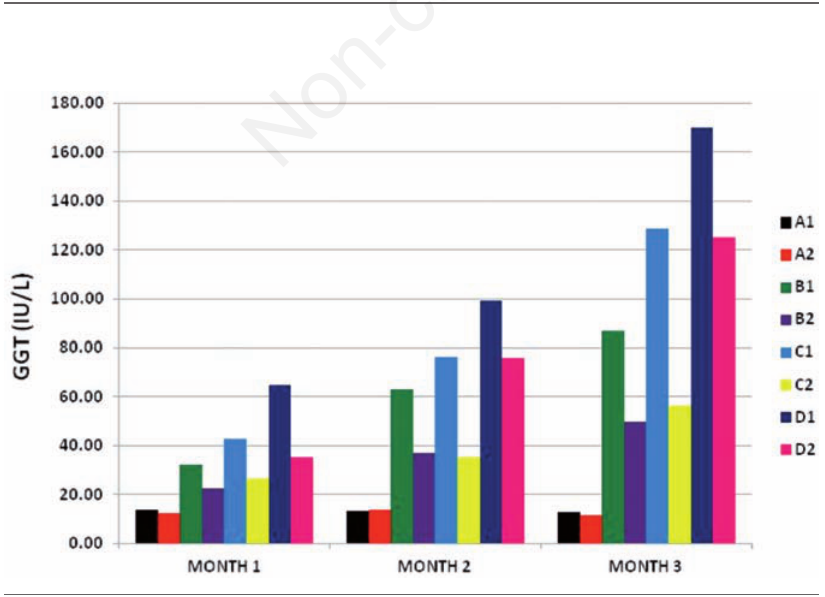
Figure 3. Alkaline phosphatase (ALP enzyme) activity values for 3 months study period.